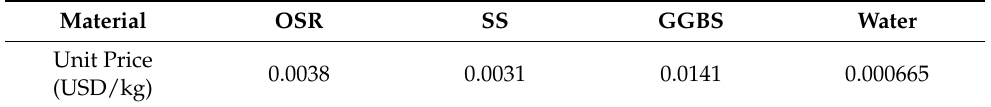
Table 2. The unit prices of raw